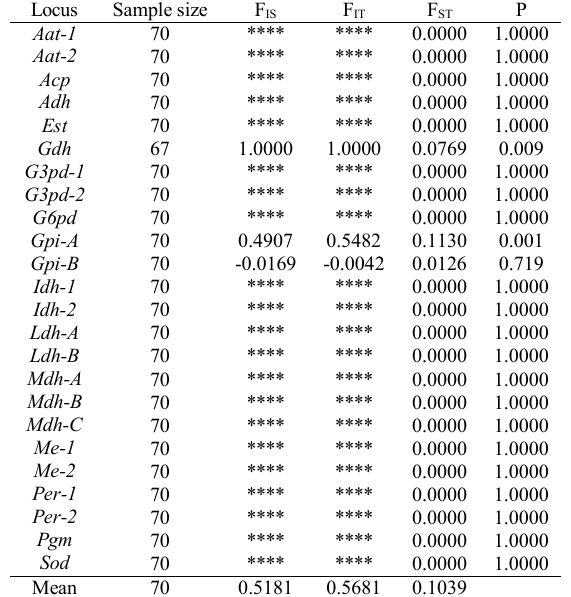
Table 3. Wright’s statistics for the four samples of Neoplecostomus yapo from the rio Paranapanema basin. P is the probability of homogeneity qui-square